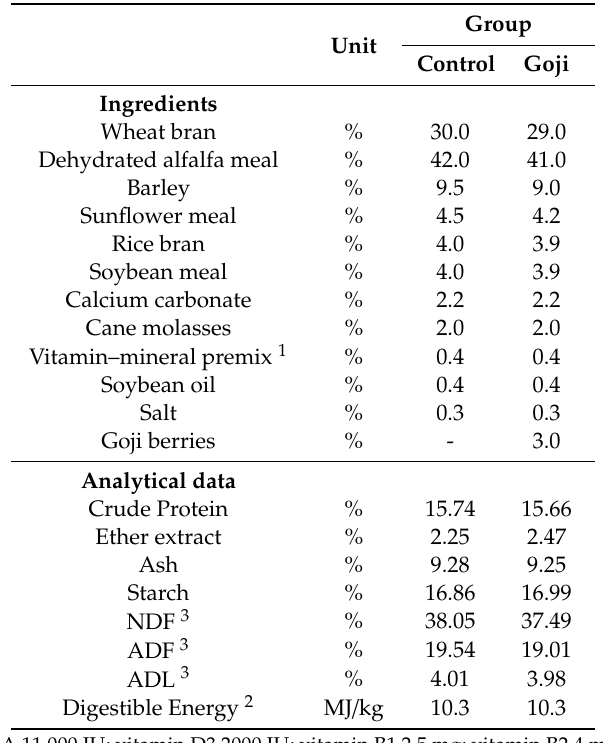
Table 1. Formulation and chemical composition (as fed) of control and experimental diet supplemented with goji